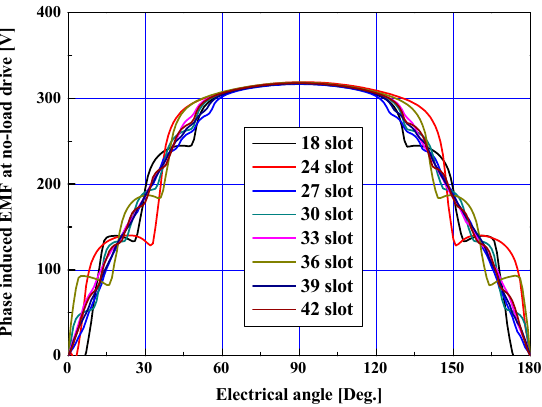
Figure 1. Wave form of the induced EMF at no-load drive according to the slot number.